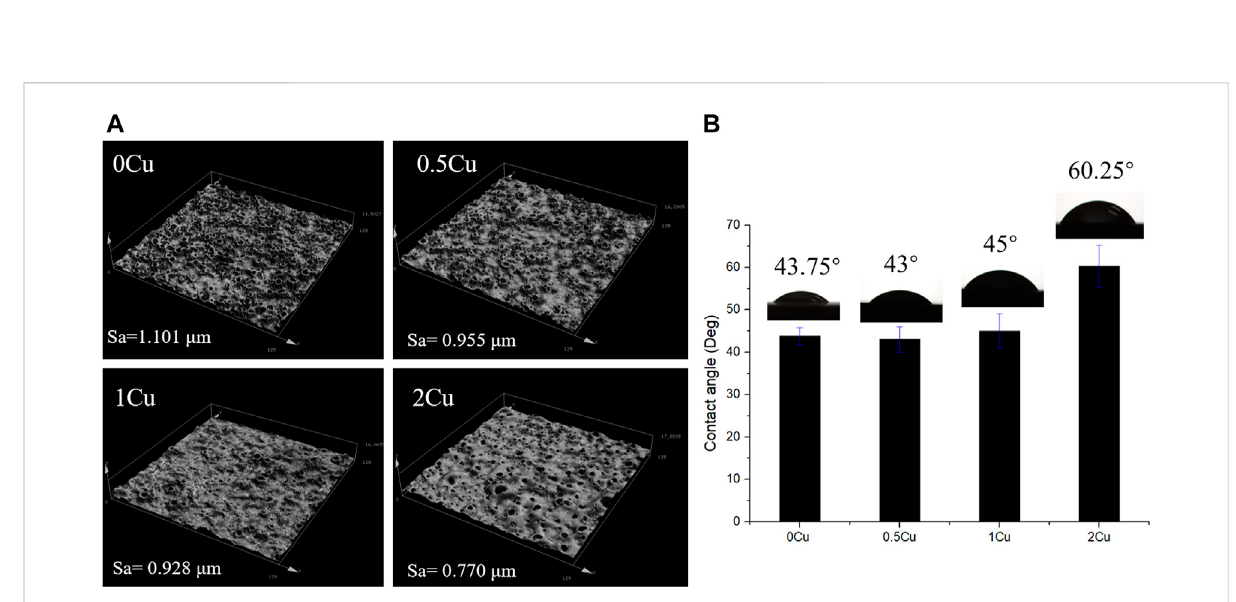
FIGURE 5 Confocal Laser Scanning Microscope images (A) and digital photograph of water droplets of different coatings (B)